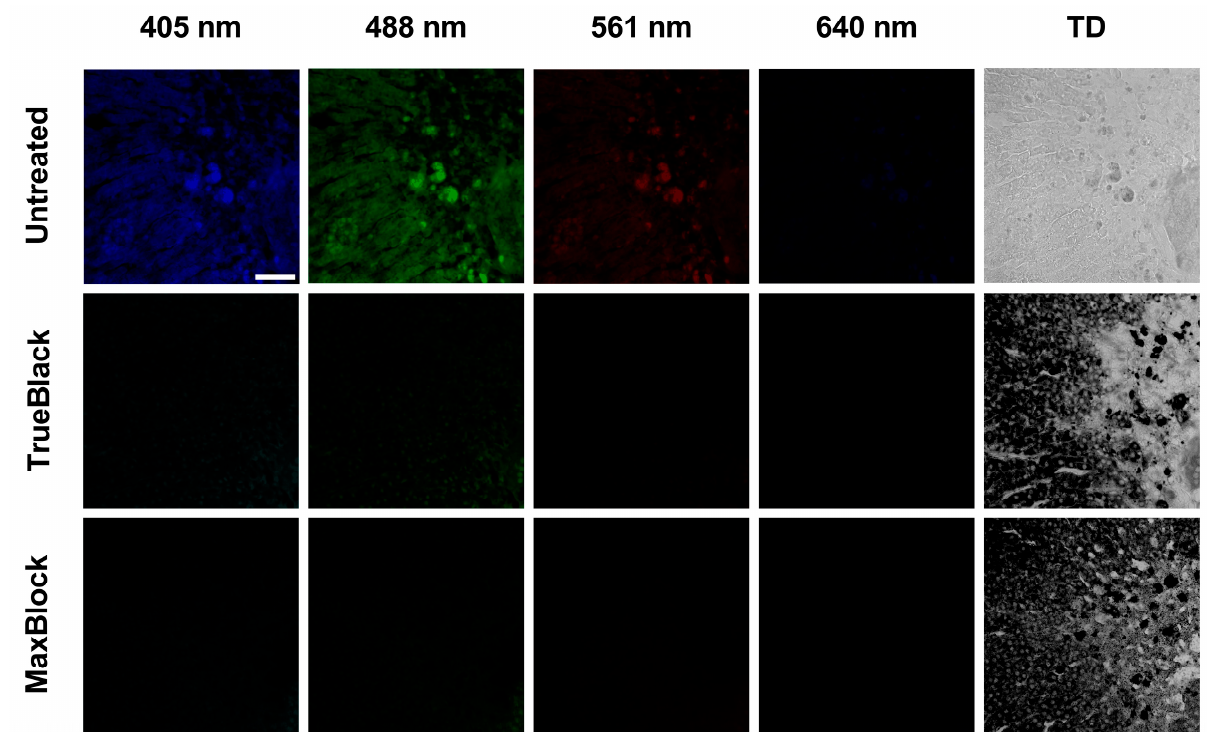
Figure 3. Reduction of autofluorescence (AF) from pigment-laden cells in the adrenal tissue of aged mice. The intense AF of lipofuscin aggregates in the adrenal tissue and the efficacy of TrueBlack and MaxBlock treatment in quenching the AF in the observed channels. Images were taken with Olympus FluoView™ FV3000 using 405, 488, 561, and 640 nm excitation and 430–470, 500–540, 570–620, and 650–750 nm detection ranges, respectively. Transmitted images were taken simultaneously at 640 nm excitation. Bar: 50 µ m. Abbreviations: TrueBlack, TrueBlack TM Lipofuscin Autofluorescence Quencher; MaxBlock, MaxBlock TM Autofluorescence Reducing Reagent Kit; TD, transmitted detec- tor.